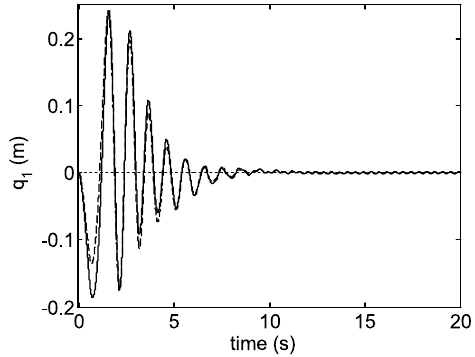
Fig. 7. Estimated (- - -) and “real” (—) behavior of measured vari- able q 1 considering same initial conditions.